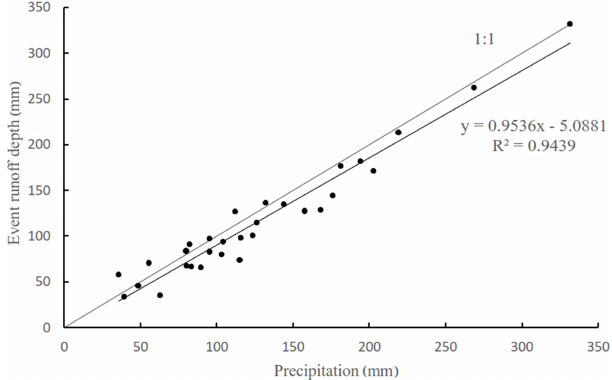
Figure 5. Event runoff depth against precipitation of 30